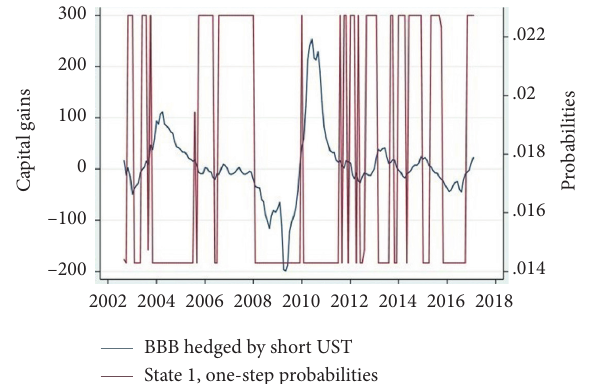
Figure 6: Regime change in means only: state plot for the capital gains hedged US BBB portfolio, 3/2002–9/2016.